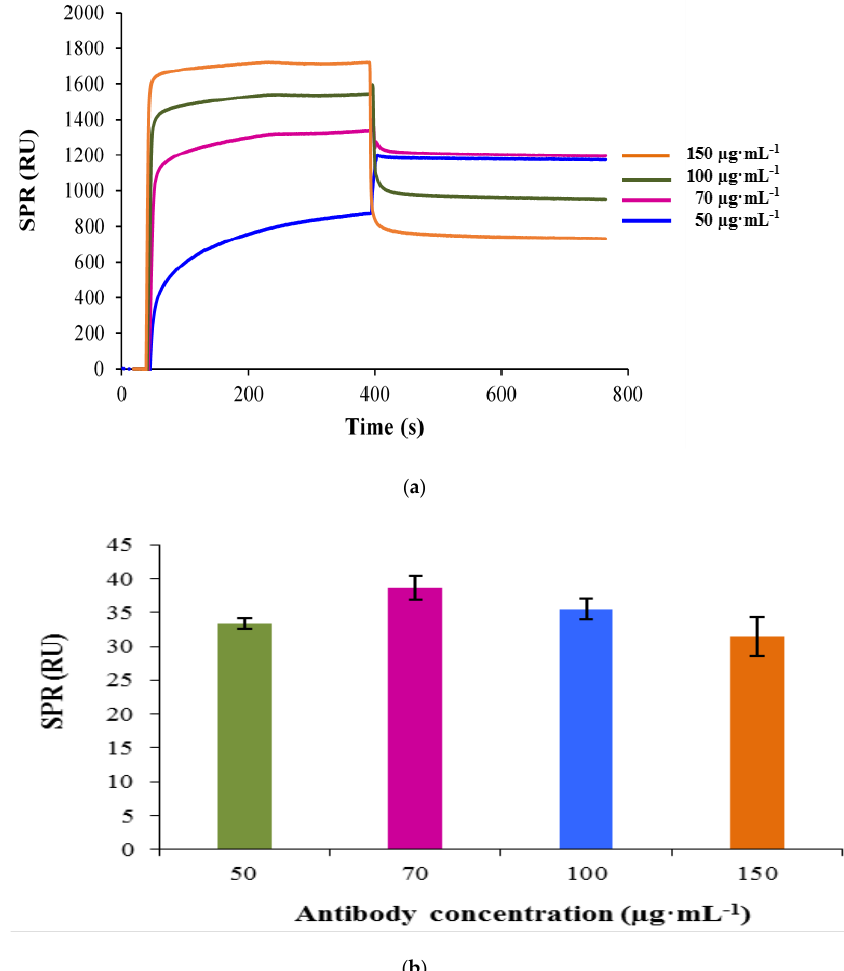
Figure 1. Concentration dependent sensorgram of the capture antibody immobilization. Mercaptoundecanoic acid (MUDA)-coated surface of gold sensor chip was activated with 1-ethyl-3- (3-dimethylaminopropyl)-carbodiimide-N-hydroxysuccinimide (EDC-NHS) prior to the antibody immobilization. Four different concentrations of the capture antibody (50, 70, 100 and 150 µg·mL −1 ) were investigated ( a ). The binding responses obtained for 1 × 10 7 CFU·mL −1 of C. jejuni based on the varying concentration of the capture antibody immobilized on the sensor surface. Bars represent the mean ± standard deviation of triplicates ( b ).